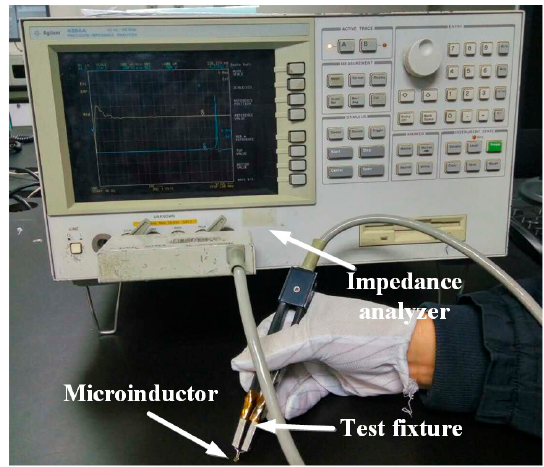
Figure 10. Frequency testing setup for the micro-inductor.